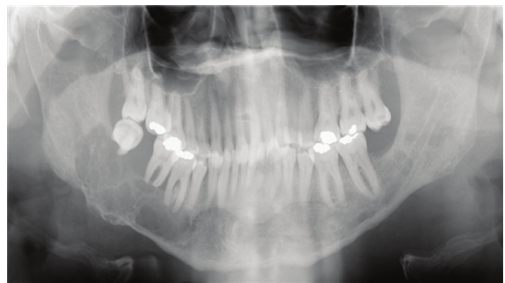
Figure 3: Panoramic radiography showing a multilocular radiolu- cency of the right